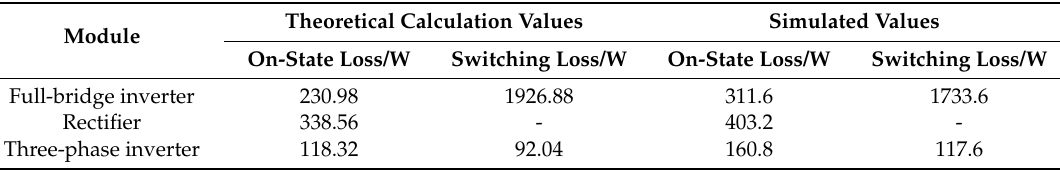
Table 3. Loss comparison of simulation and theory.